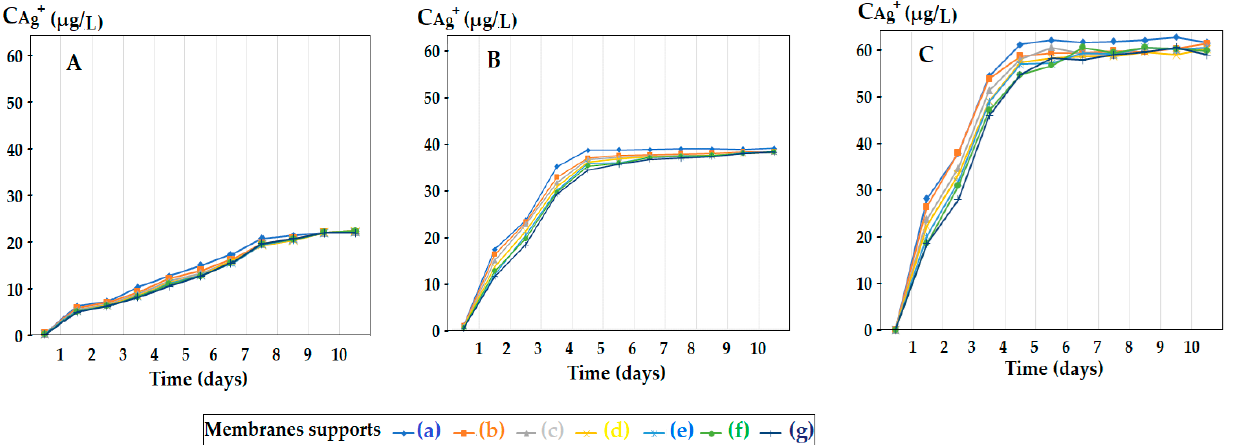
Figure 9. Concentration of silver ions released in the receiving aqueous phase of pH = 7, as a function of time, for seven morphologies of the polysulfone support and for oxide nanoparticles containing silver: ( A ) 0.55%, ( B ) 1.12% and ( C ) 1.63%.